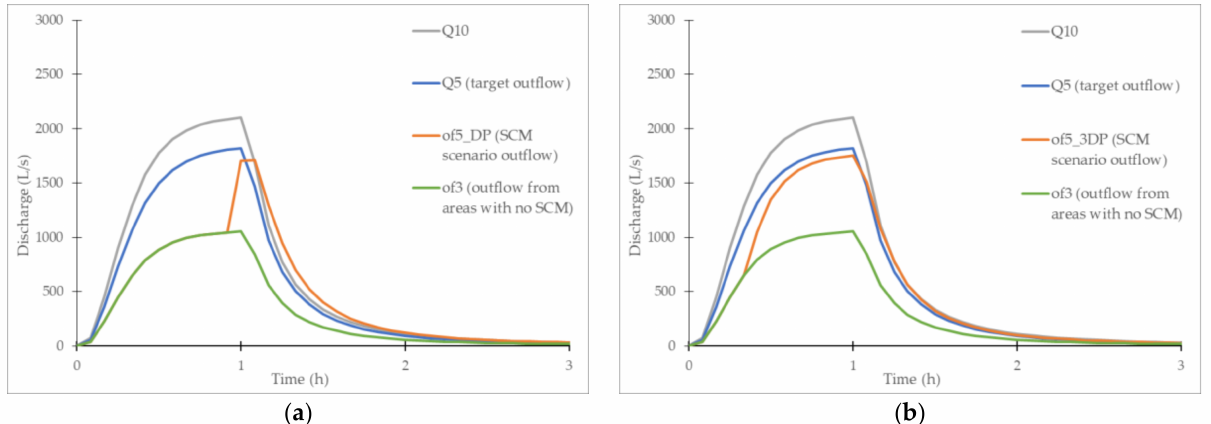
Figure 5. The results of the DP scenario ( a ), which includes one type of a detention pond, and the 3DP scenario ( b ), which includes three types of a detention pond, for